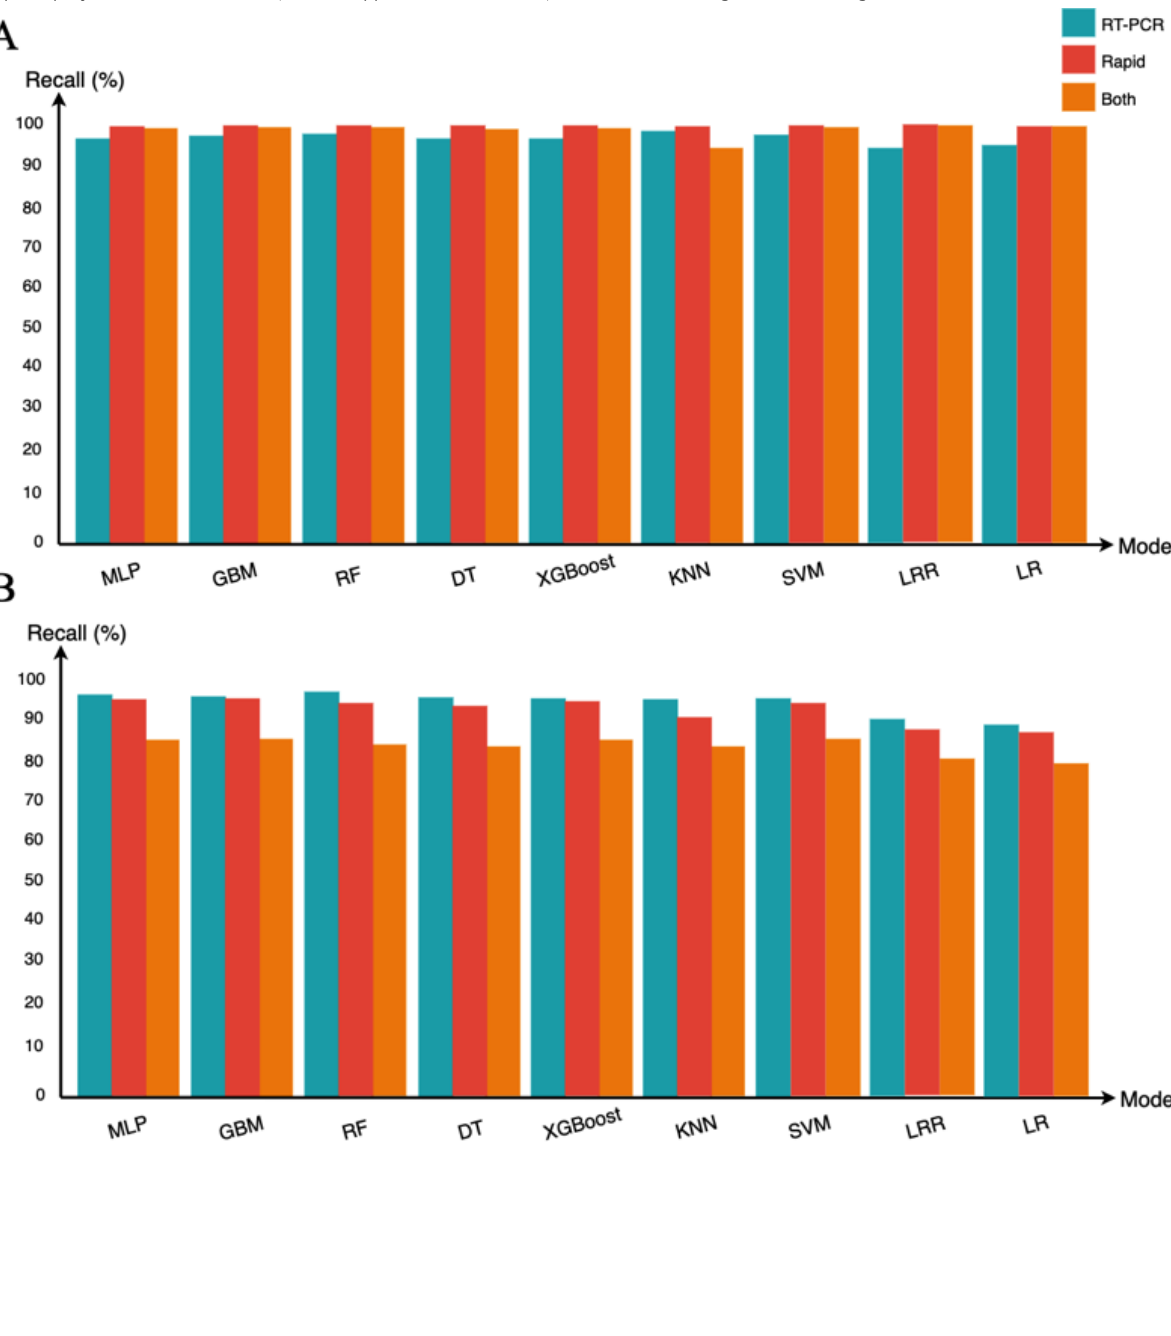
Figure 6. (A) The mean recall for the MLP, GBM, RF, DT, XGBoost, KNN, SVM, LRR, and LR classification models using the unbalanced data sets for RT-PCR, rapid, and both types. (B) The mean recall for the MLP, GBM, RF, DT, XGBoost, KNN, SVM, LRR, and LR classification models using the balanced data sets for RT-PCR, rapid, and both types. DT: decision tree; GBM: gradient boosting machine; KNN: k-nearest neighbors; LR: logistic regression (weak regularization); LRR: logistic regression (strong regularization); MLP: multilayer perceptron; RF: random forest; RT-PCR: